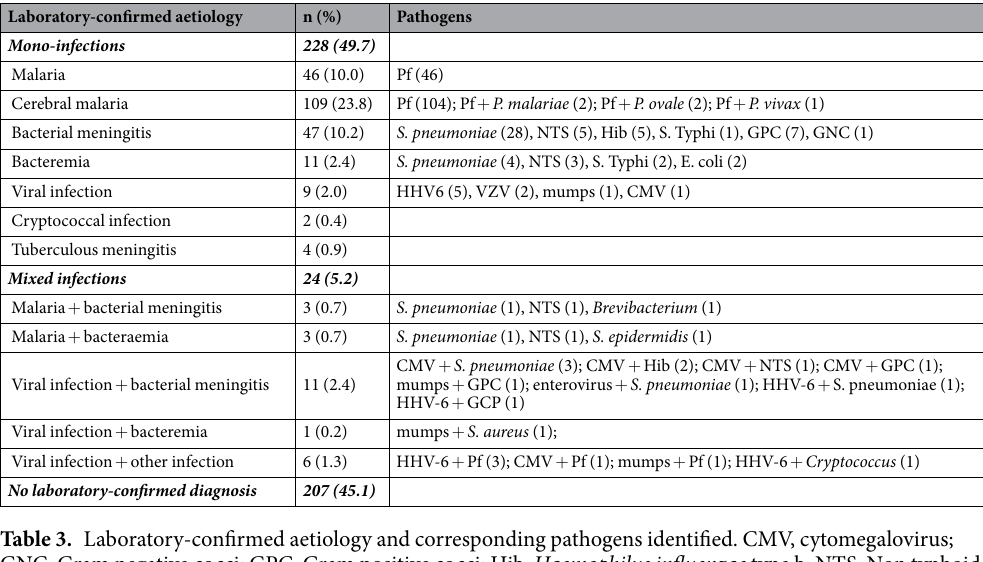
Table 3. Laboratory-confirmed aetiology and corresponding pathogens identified. CMV, cytomegalovirus; GNC, Gram negative cocci; GPC, Gram positive cocci; Hib, Haemophilus influenzae type b; NTS, Non typhoidal